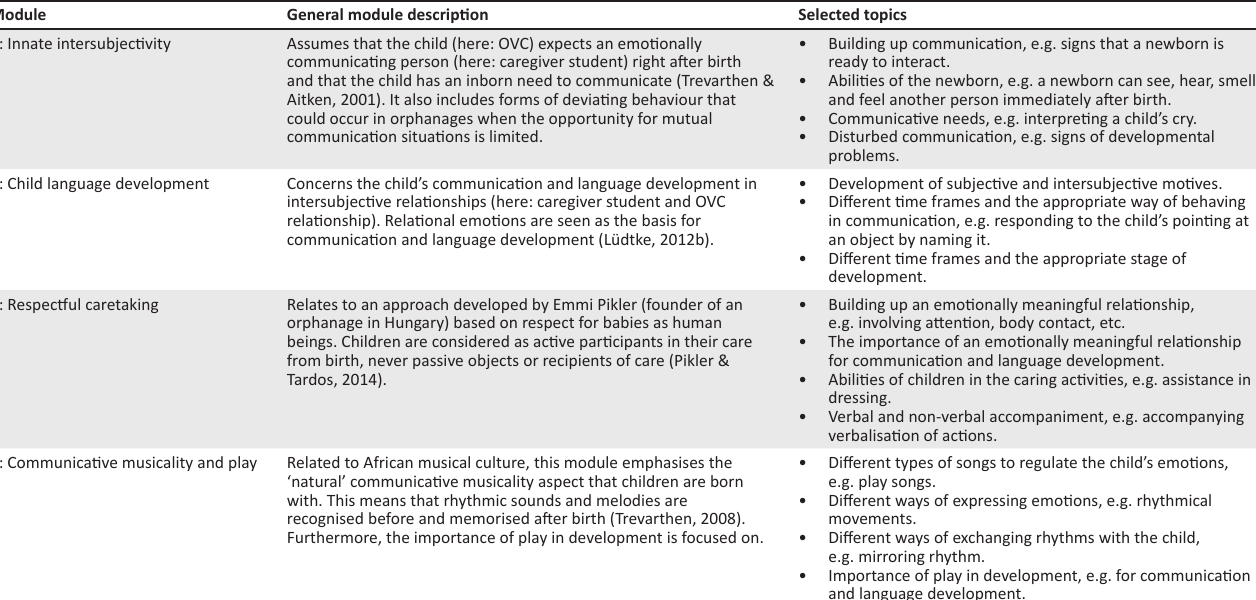
FIGURE 1: Adapted, culturally sensitive relational language didactics triangle. TABLE 1: Adapted, culturally sensitive training modules. Module General module description Selected